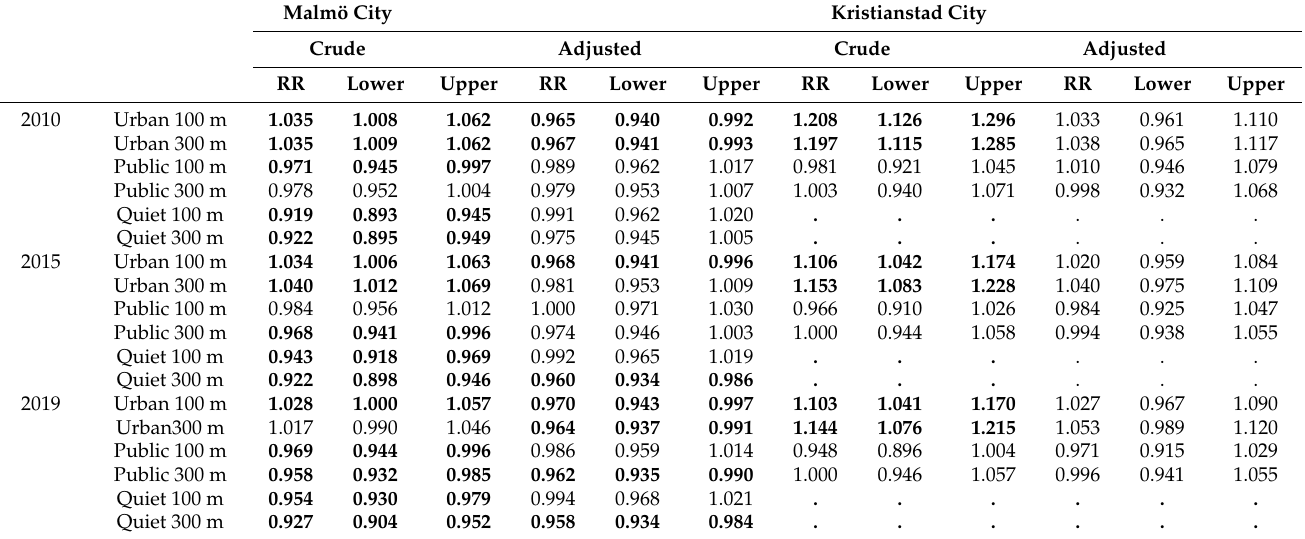
Table A2. Risk ratios for crude and multivariate associations between men vs women study partici- pants in availability to total urban green space (Urban), publicly available urban green space (Public) and quiet publicly available urban green space (Quiet). RR for 100 m and 300 m buffer distances from the residence for the three different types of urban green spaces are